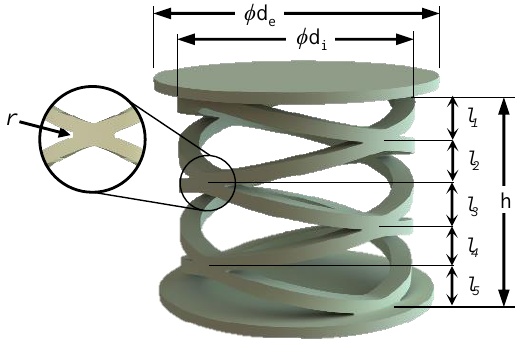
Figure 3. Cylindrical arch spring structure.